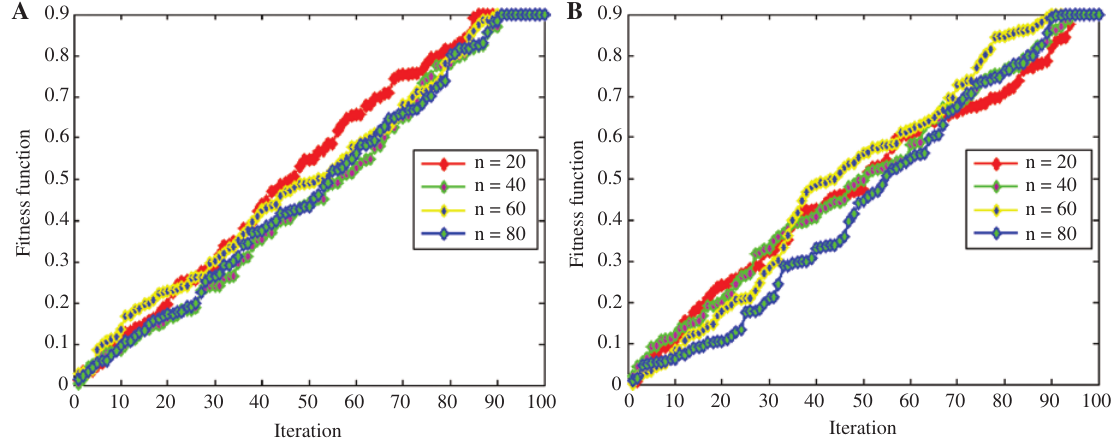
Figure 3: Convergence Analysis. (A) p = 10. (B) p =